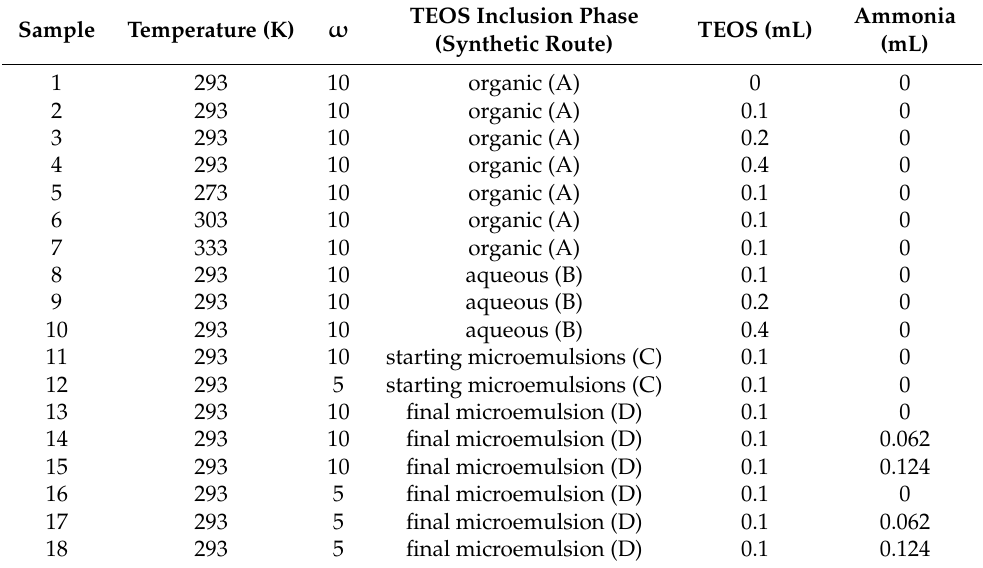
Table 1. Experimental conditions for reverse micelle syntheses of [Fe(H-trz) 2 (trz)]BF 4 @SiO 2 nanoparticles with the Triton X-100/cyclohexane/water ternary system (volume given for the final microemulsion).